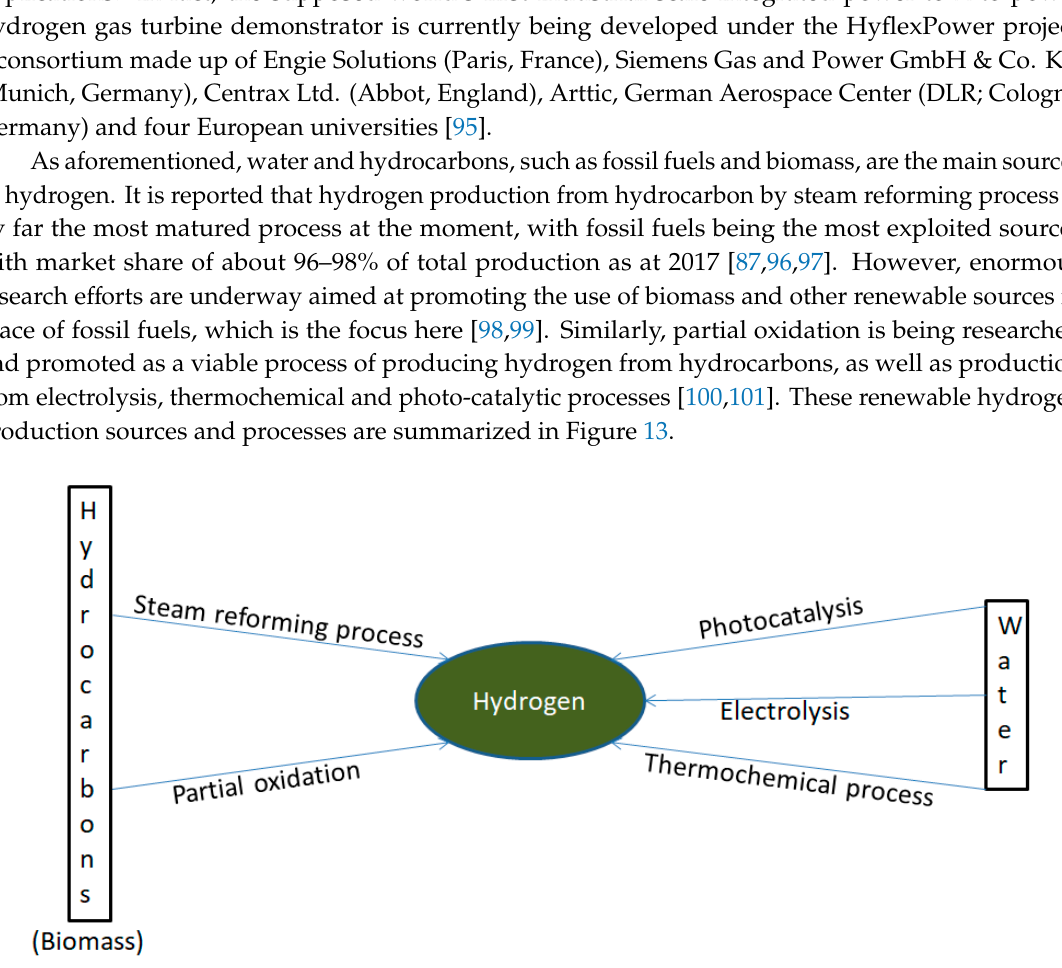
Figure 14. Classifications of fuel cells. 3. Challenges at Power Generation Phase